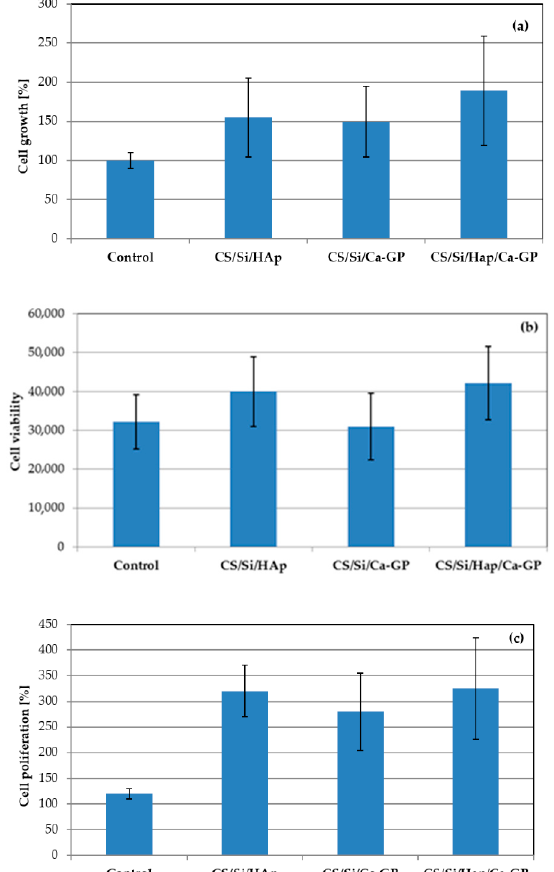
Figure 8. Cell growth ( a ), viability ( b ), and proliferation results ( c ) of CS/Si/HAp, CS/Si/Ca-GP, CS/Si/HAp/Ca-GP composites. CS/Si/HAp/Ca-GP